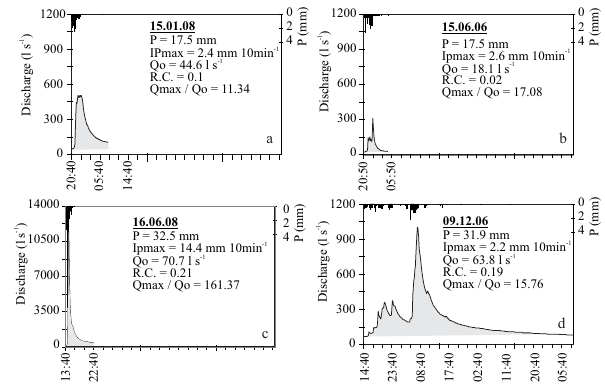
Fig. 8. Example of events with different hydrological response. Precipitation ( P , mm), maximum intensity of precipitation (mm10min − 1 ), initial discharge ( Q o , Ls − 1 ), runoff coefficient (RC) and discharge increase ( Q max / Q o ) are included for each